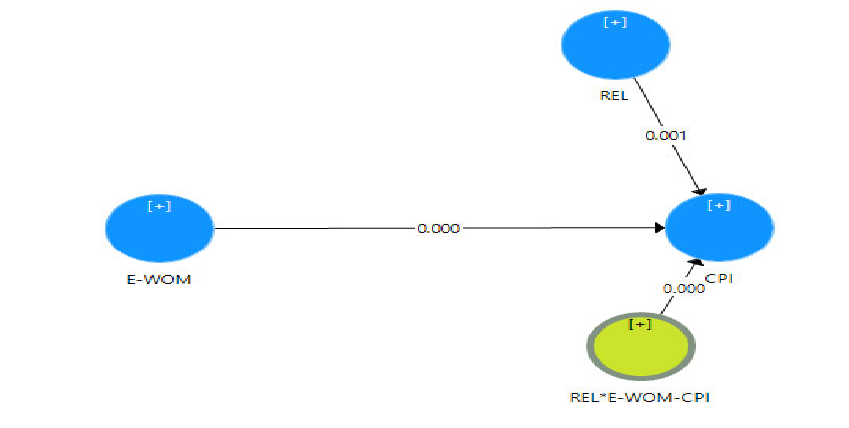
Fig. 2 . Model of a structure